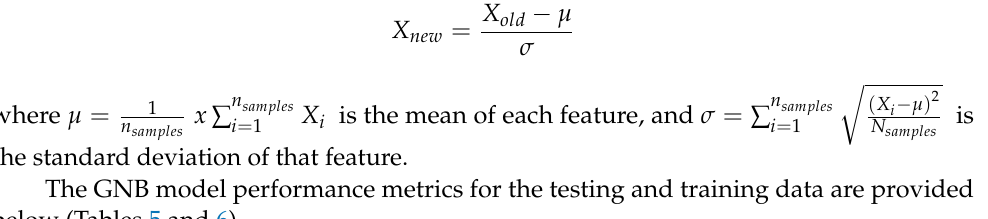
Table 5. Performance Metrics for Testing Data.